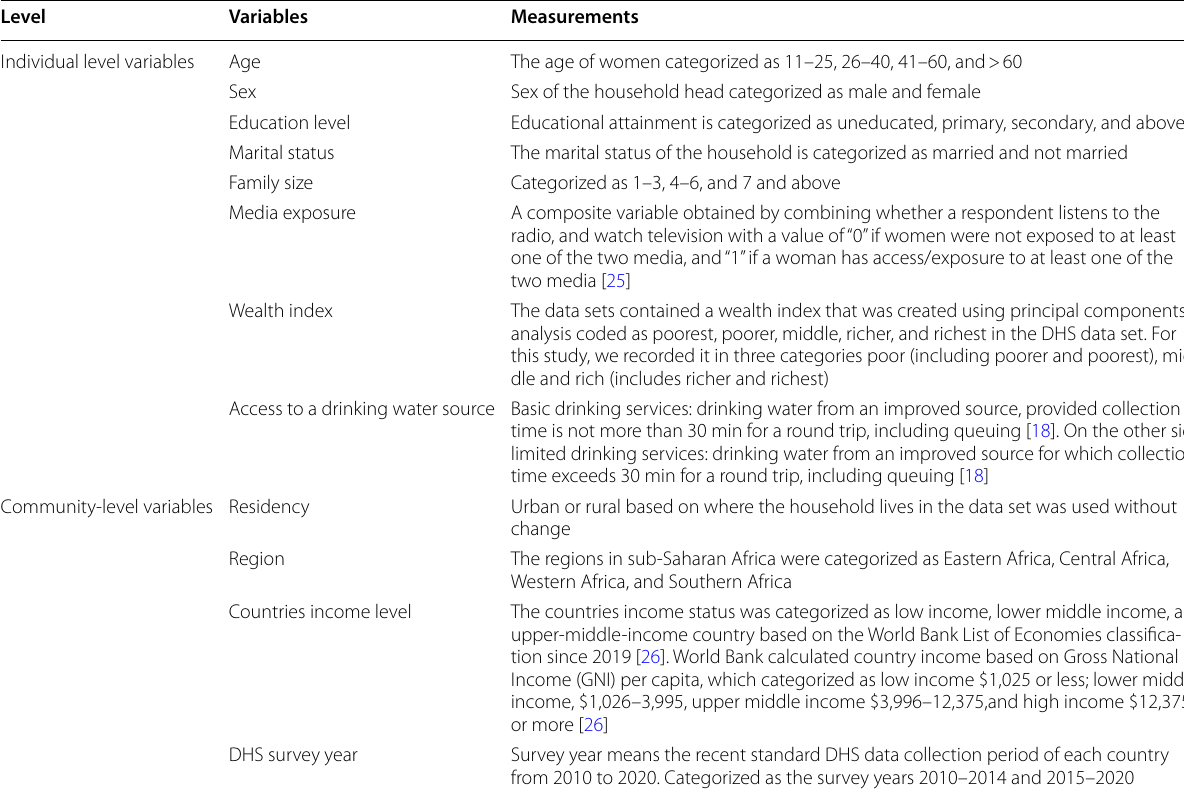
Table 2 List of the independent variables used in the study with their measurement descriptions